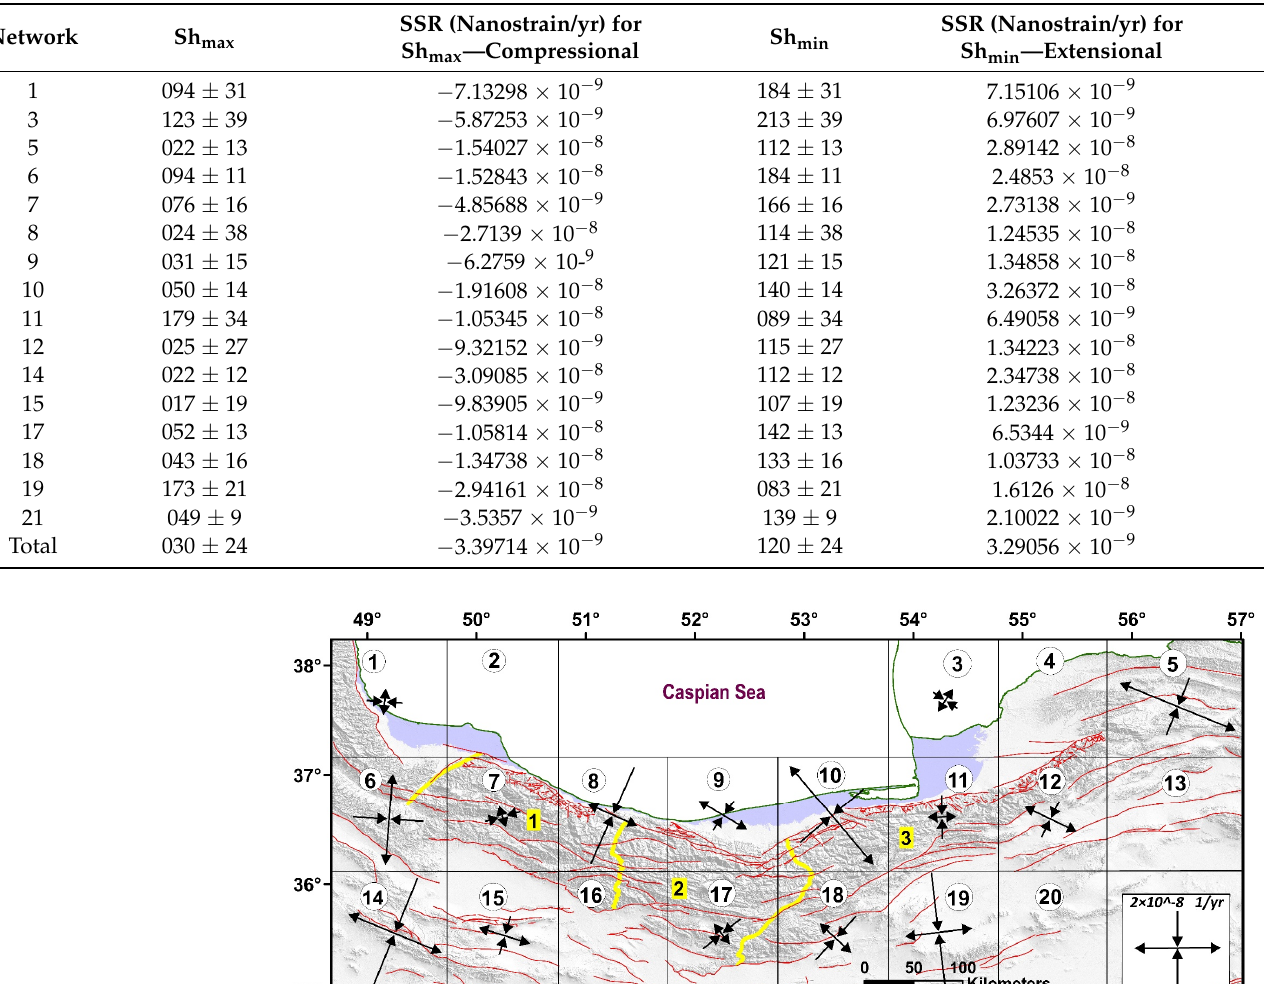
Table 4. The azimuths and values of the compressional and extensional axes of SSR in the area.